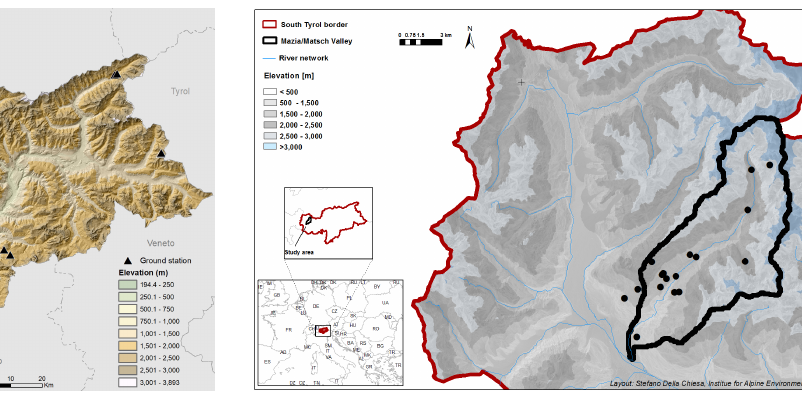
( b ) Ground station network overview in Val Mazia, Matsch area. Figure 2. South Tyrol network of ground stations.